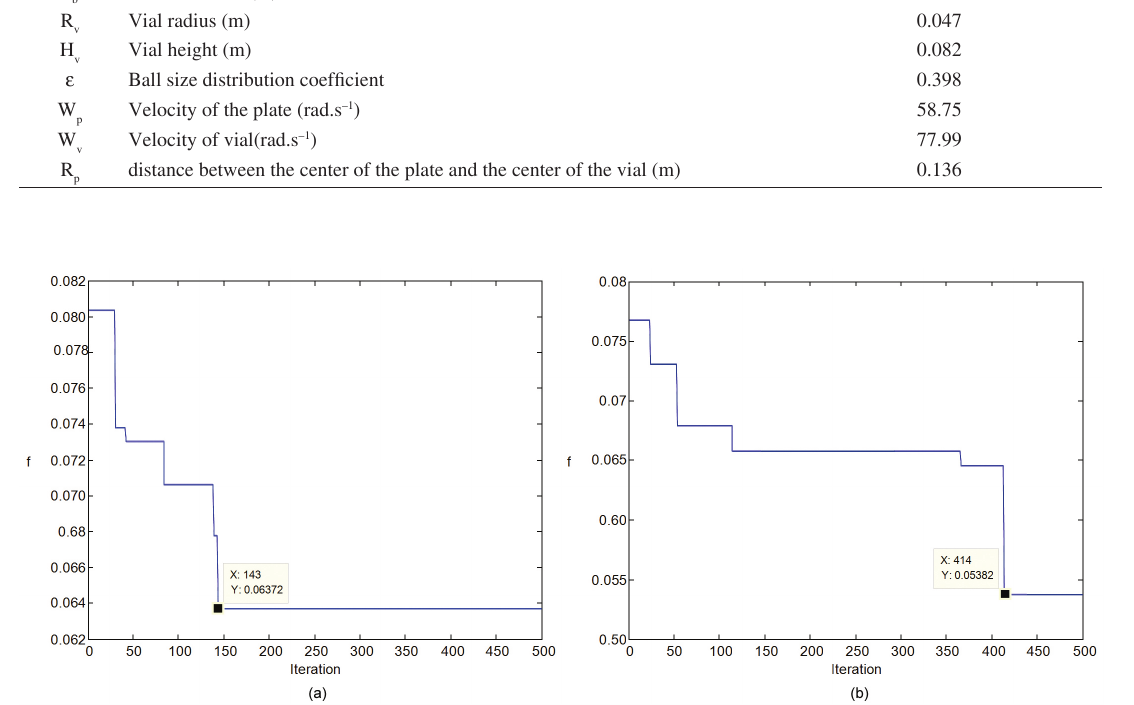
Figure 11. Convergence of the a) ABC and b) BBO algorithms to the optimal